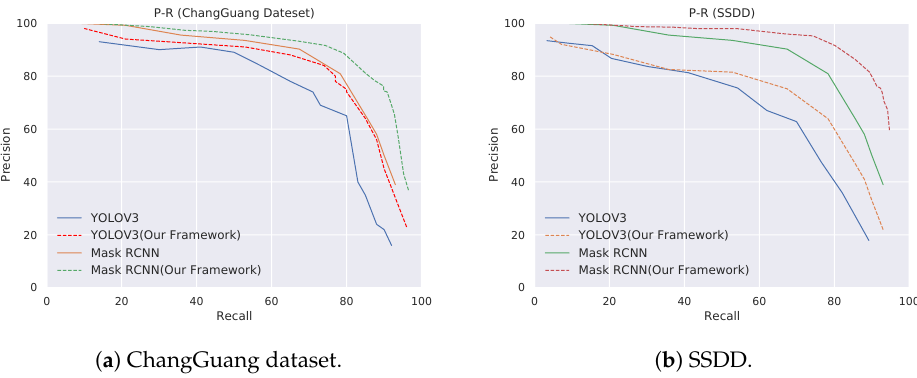
Figure 12. Precision–recall curve for the datasets. Plotted results show the detection performance of our detection